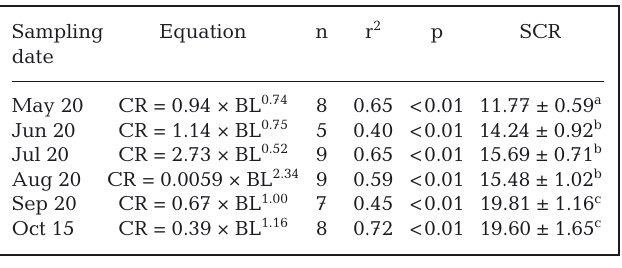
Table 2. Allometric relationship between clearance rate (CR; l h −1 ) and body length (BL; cm), and standardized clearance rates (SCR; l h −1 ) of 30 cm silver carp Hypophthalmichthys molitrix . For SCR, data are presented as means ± 1 SD. Different superscript letters indicate a significant difference between monthly sampling dates in 2011 (p < 0.05)